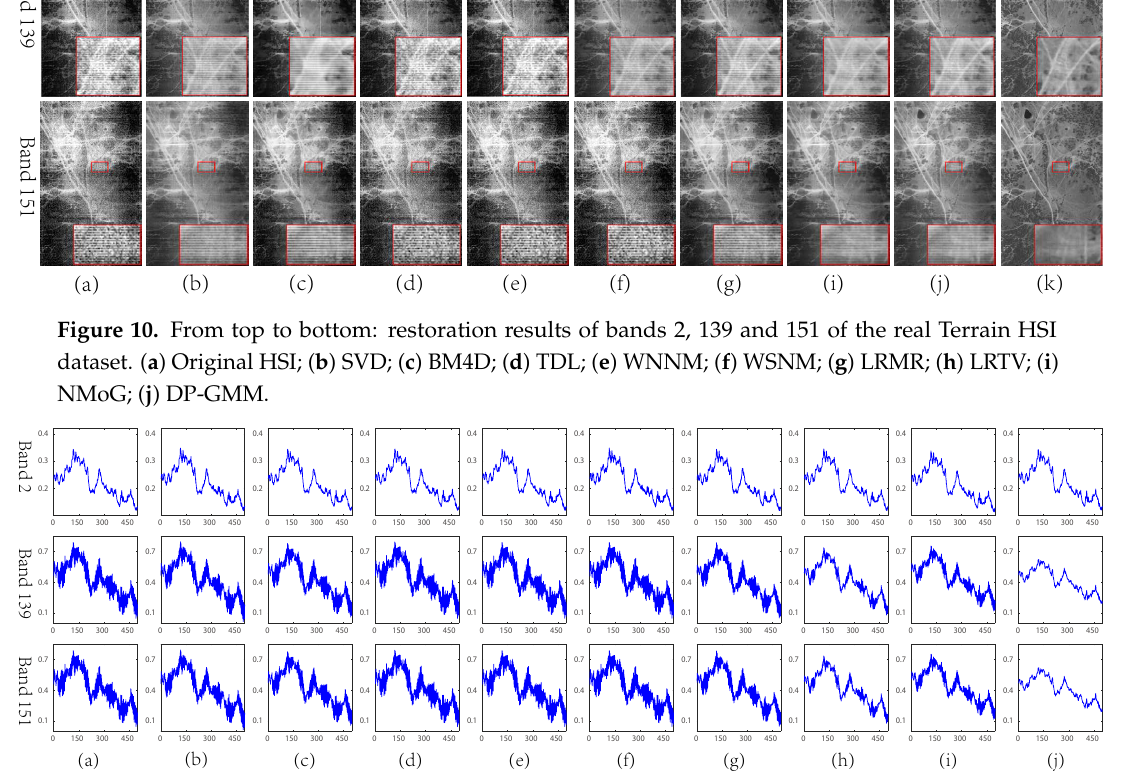
Figure 11. Vertical mean profiles of some typical bands in the Terrain HSI dataset. From top to bottom: band 2 (top), band 139 (middle) and band 151 (down). From left to right: ( a ) Original HSI; ( b ) SVD; ( c ) BM4D; ( d ) TDL; ( e ) WNNM; ( f ) WSNM; ( g ) LRMR; ( h ) LRTV; ( i ) NMoG; ( j )